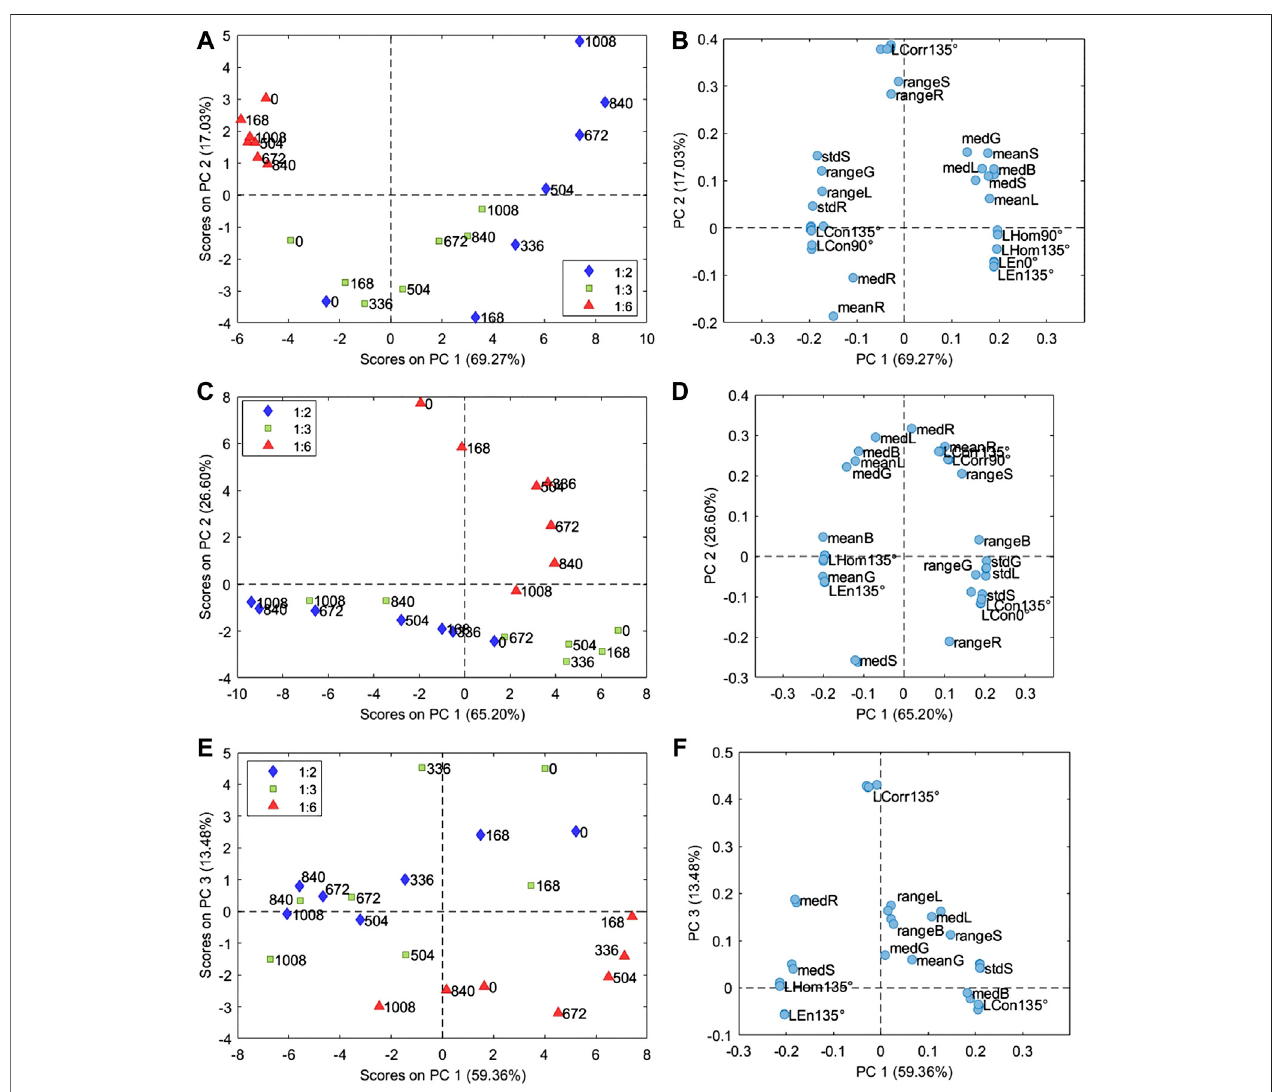
FIGURE3| ScoreandloadingplotsofthePCAmodelscalculatedontheimagefeaturesmatrix( SupplementaryTableS1 )obtainedfromthemicroscopicimages of samples of alkyd resin mixed with PB29 (A,B) , PG18 (C,D) , and PY37 (E,F) . The samples in the score plot are colored according to the P/BM ratio, while the labels indicate the aging time from 0 to 1,008